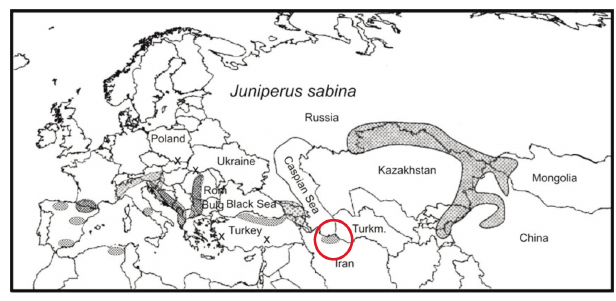
Fig. 1 ­ The worldwide distribution of different populations of Juniperus sabina (in grey) and the sampling area of stem cuttings (in a red circle) (Adams and Schwarzbach,